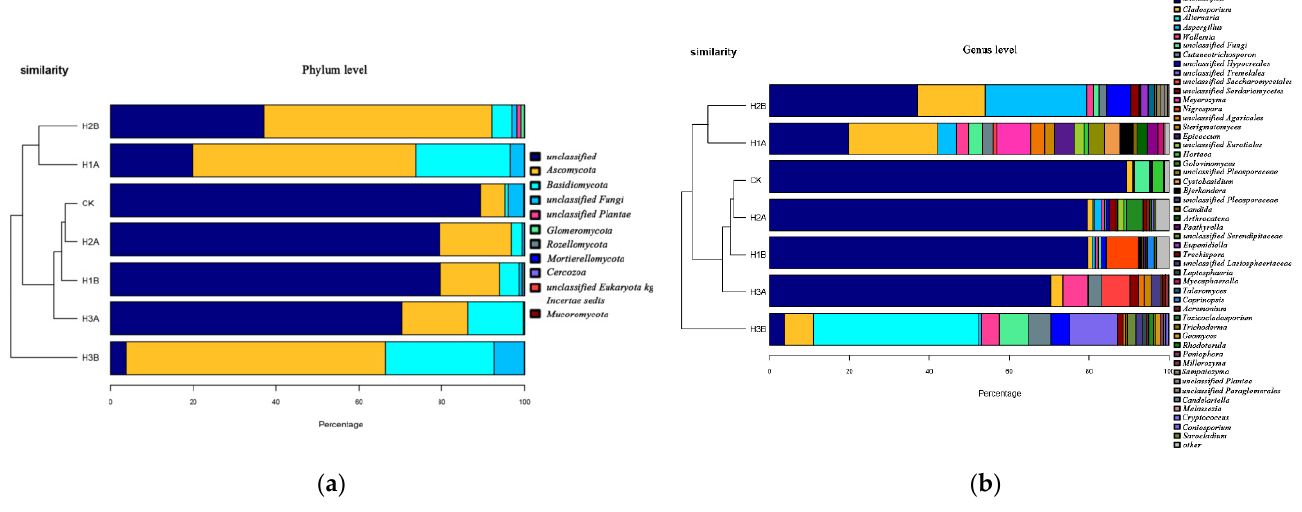
Microorganisms 2022 , 10 , x FOR PEER REVIEW 12 of 16 Figure 7. Effects of C. vulgaris LH-1 addition on fungal communities in seawater containing 10.00 g/L crude oil and different nutrient concentrations. ( a ) Phylum Level. ( b ) Genus Level.